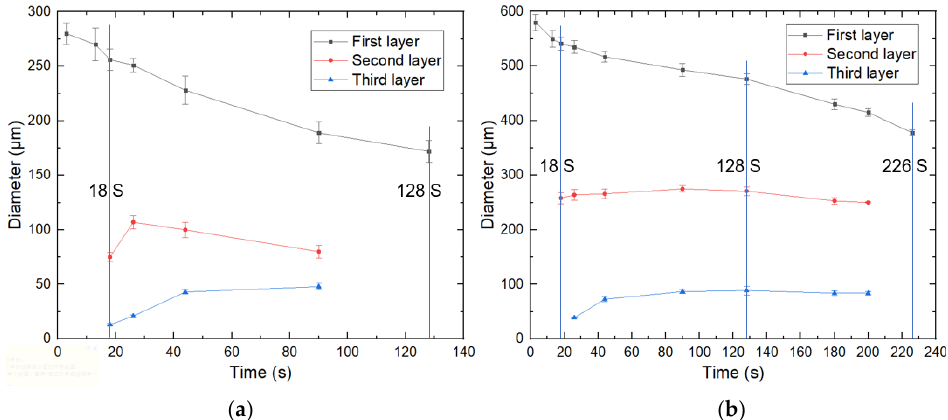
Figure 7. Diameter variation of each layer of droplets with different initial sizes: ( a ) 280 µm; ( b ) 580 µm.